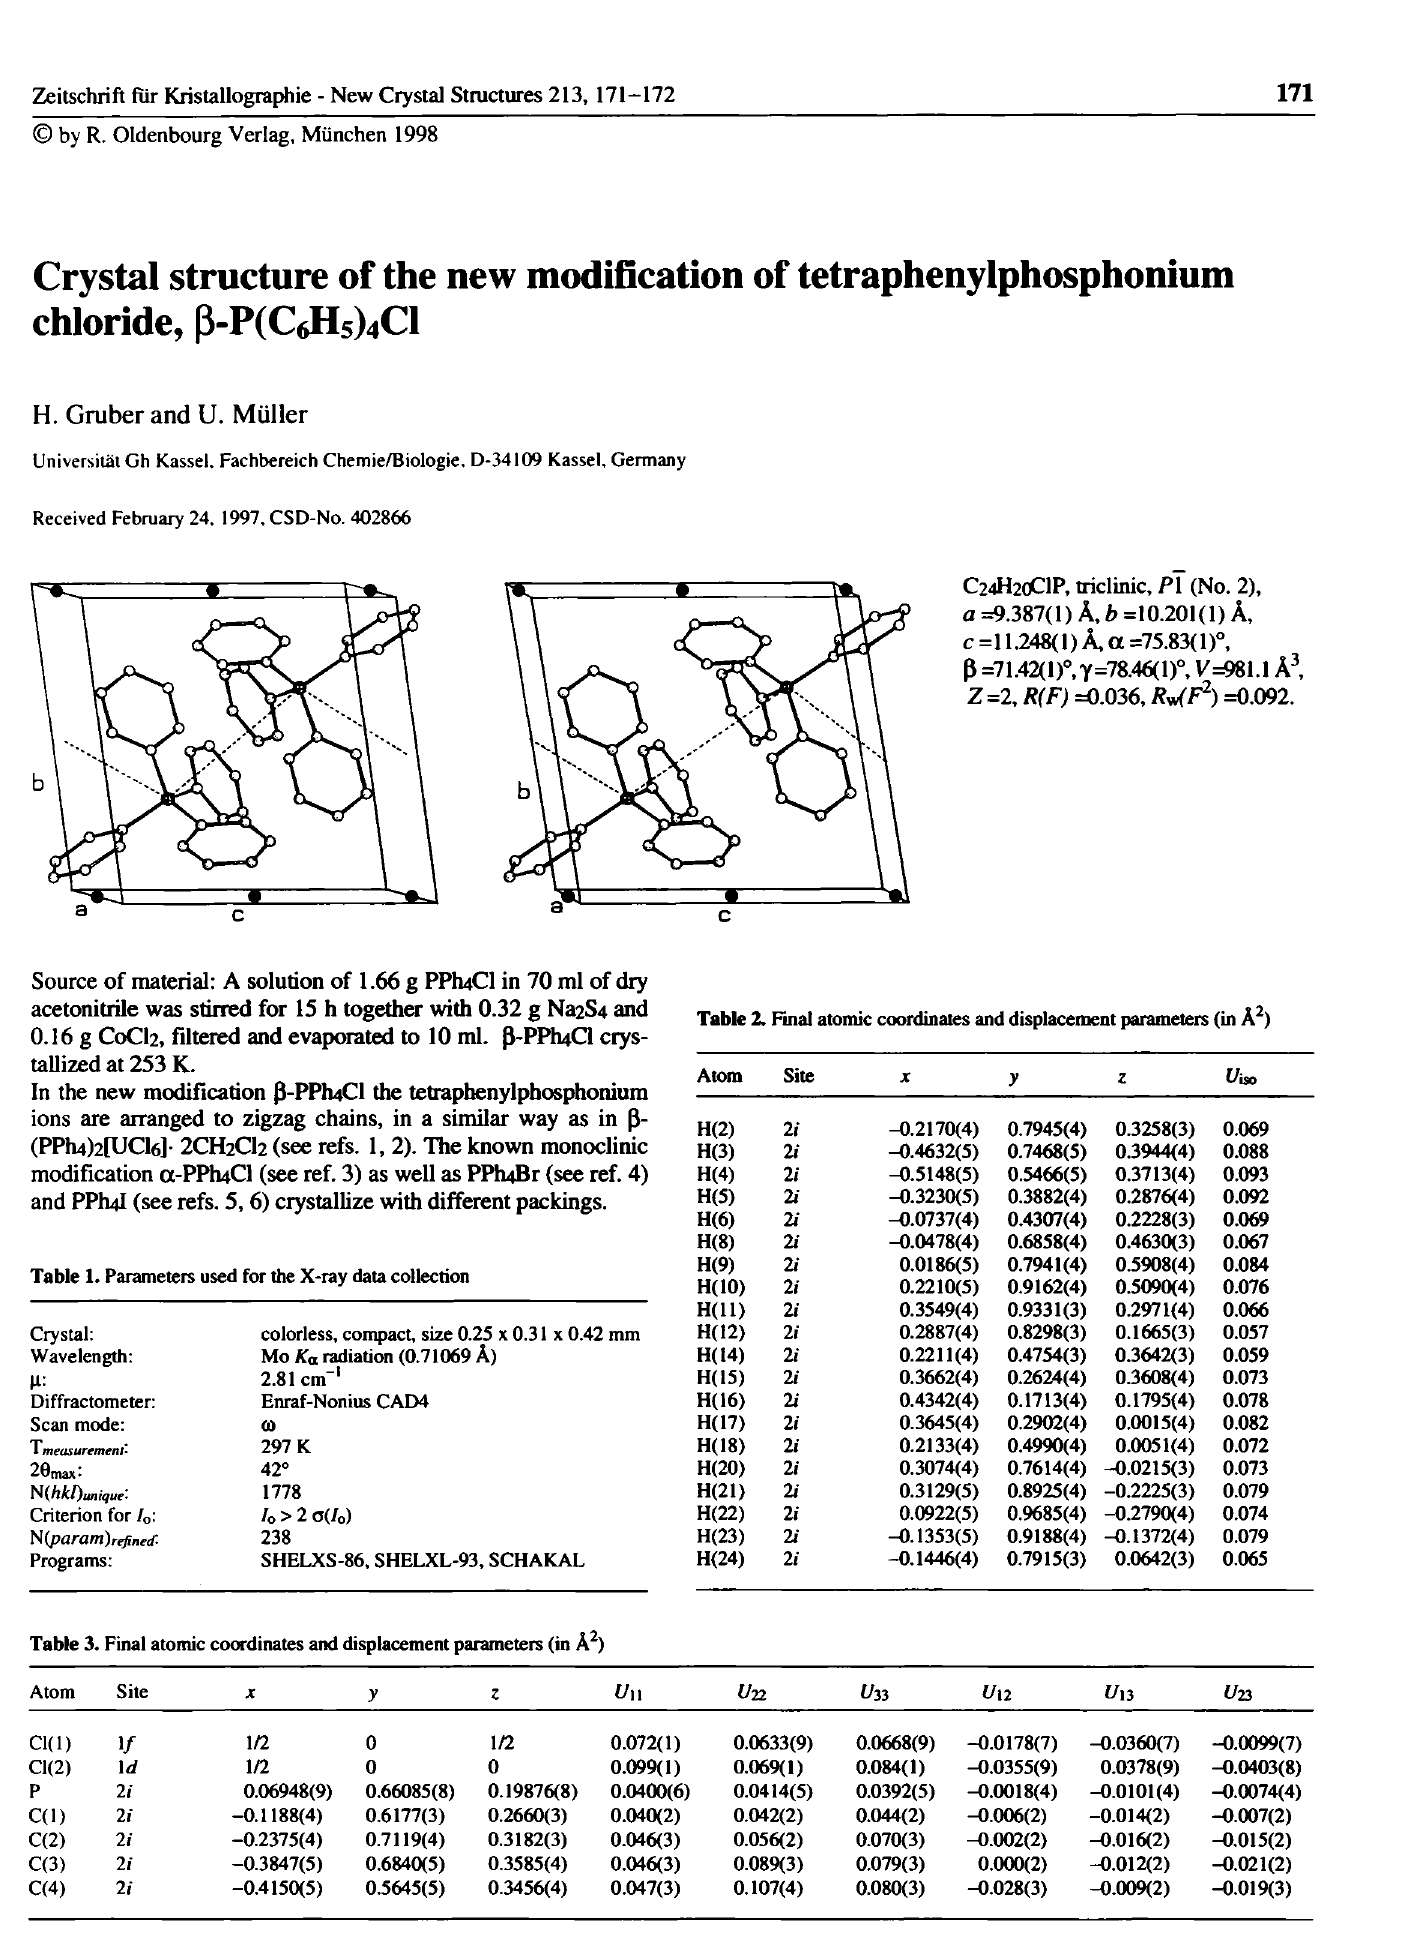
Table 3. Final atomic coordinates and displacement parameters (in A^)